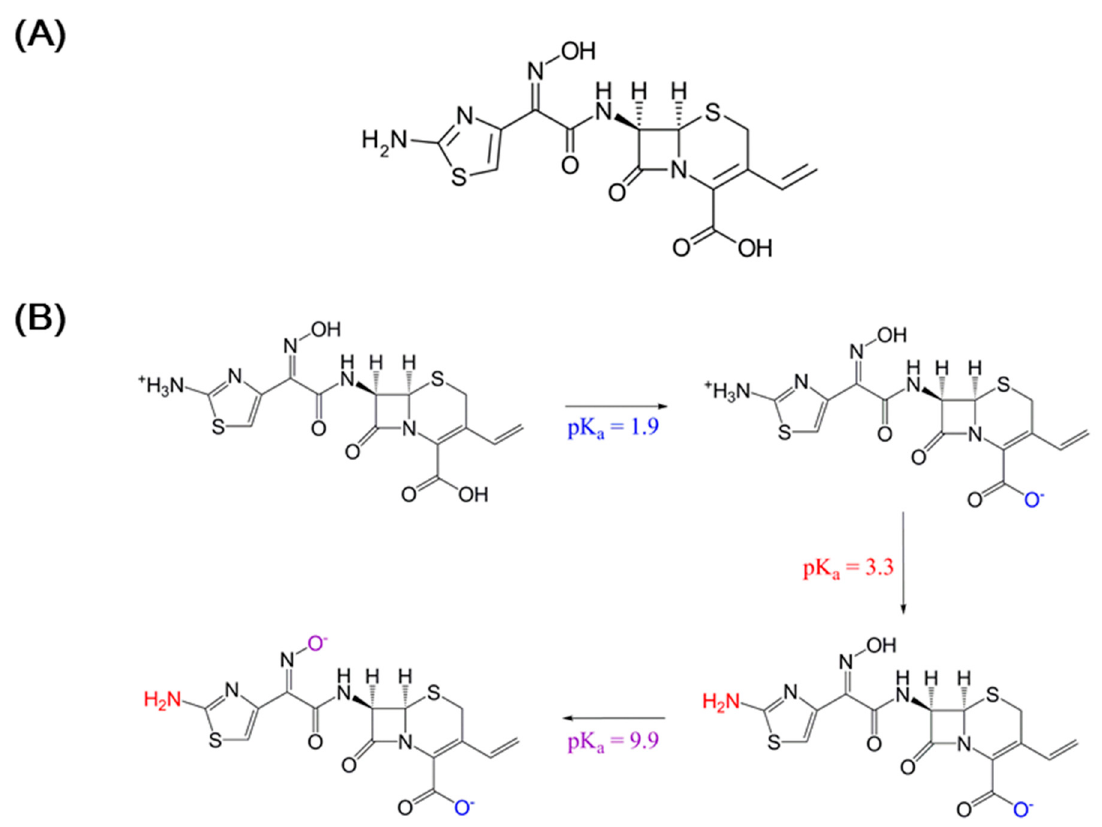
Figure 1. Chemical structure of cefdinir ( A ) and its pH-dependent structural change ( B ).